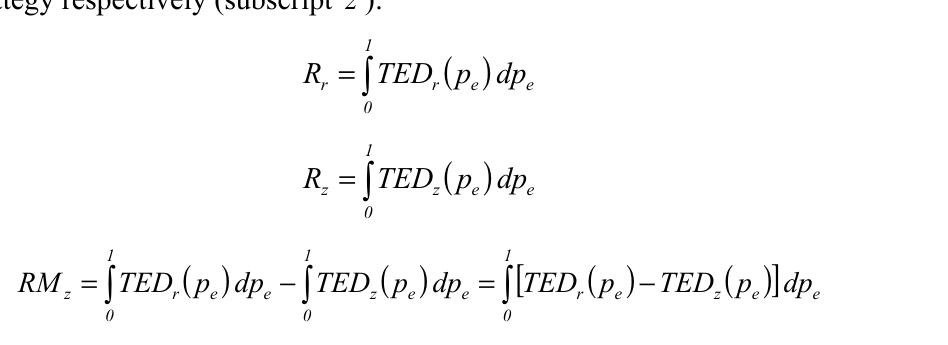
Figure 4. Graphical representation of the risk mitigation performance strategy z